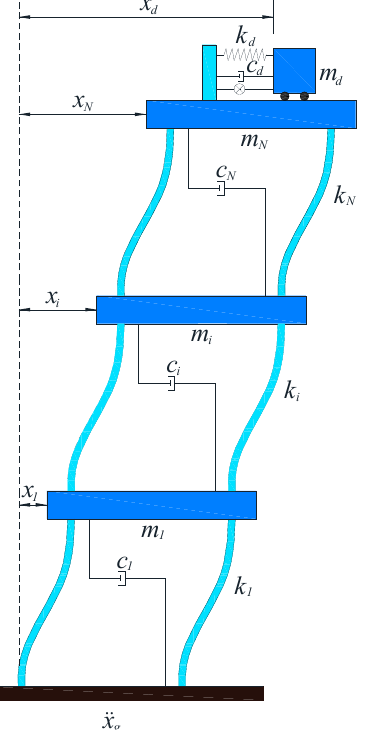
Figure 3. A structural model with ATMD on the top.